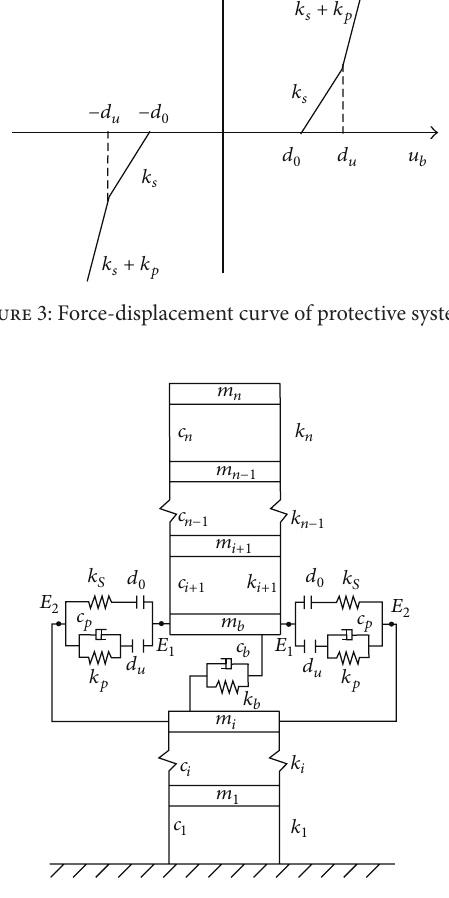
Figure 4: Mechanical model of a midstory isolated building with protective